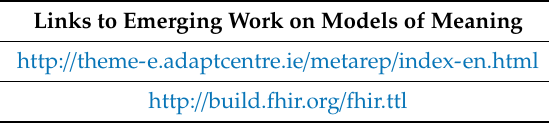
Table 2. Links to emerging work on models of meaning. Links to Emerging Work on Models of